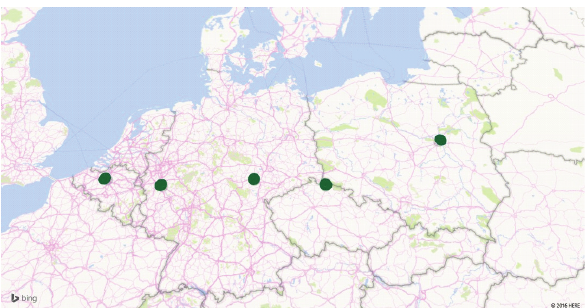
Figure 1: Geographic locations of tested samples of E. brasiliensis . From left-hand side: Belgium, Meise (Ebe); Germany, Bonn (Ebo); Germany, Jena (Eje); Czech Republic, Liberec (Eli); Poland, Warsaw (Epo).